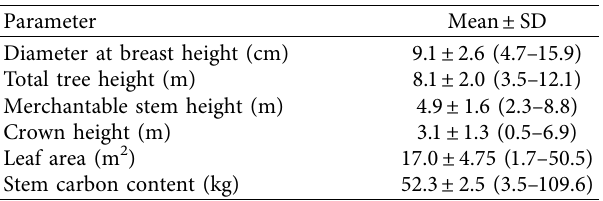
Table 1: The descriptive statistics of the tree parameters of Rhi- zophora mucronata